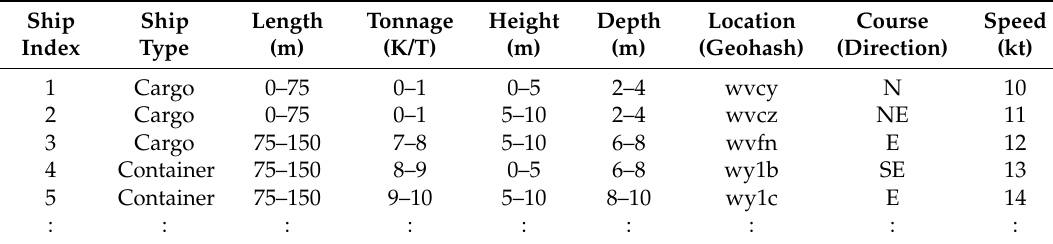
Table 2. Ship indices and their associated attribute values.